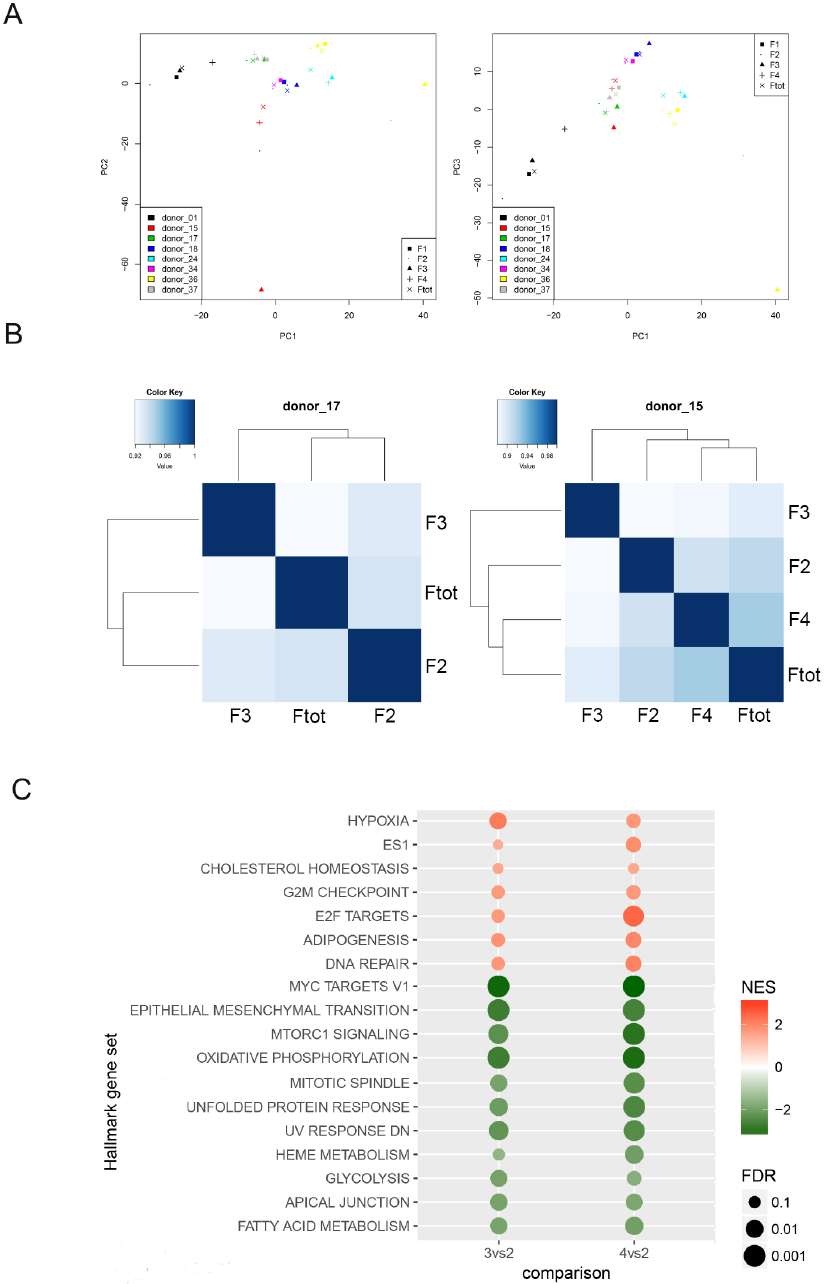
Figure 3. RNSseq analysis of hAFSCs fractions. ( A ) Principal component analysis reporting distribu- tion of 8 samples along the principal component 1 (PC1), principal component 2 (PC2) and principal component 3 (PC3). The heterogeneity among patients and fractions can be noticed. ( B ) Two graphs of Pearson Correlation Analysis representative of samples sorted in 3 or 4 fractions are shown in order to highlight the heterogeneity among the fractions. ( C ) Pathways differently expressed with the same trend for both F3 versus F2 and F4 versus F2. 18 pathways differently expressed according to software Gene Set Enrichment Analysis (GSEA) analysis and hallmark dataset. In red pathways upregulated in F3 and F4, while in green pathways downregulated in these fractions compared to F2. The table represents the Normalized Enrichment score (NES) and the False discovery rate value (FDR). FDR <